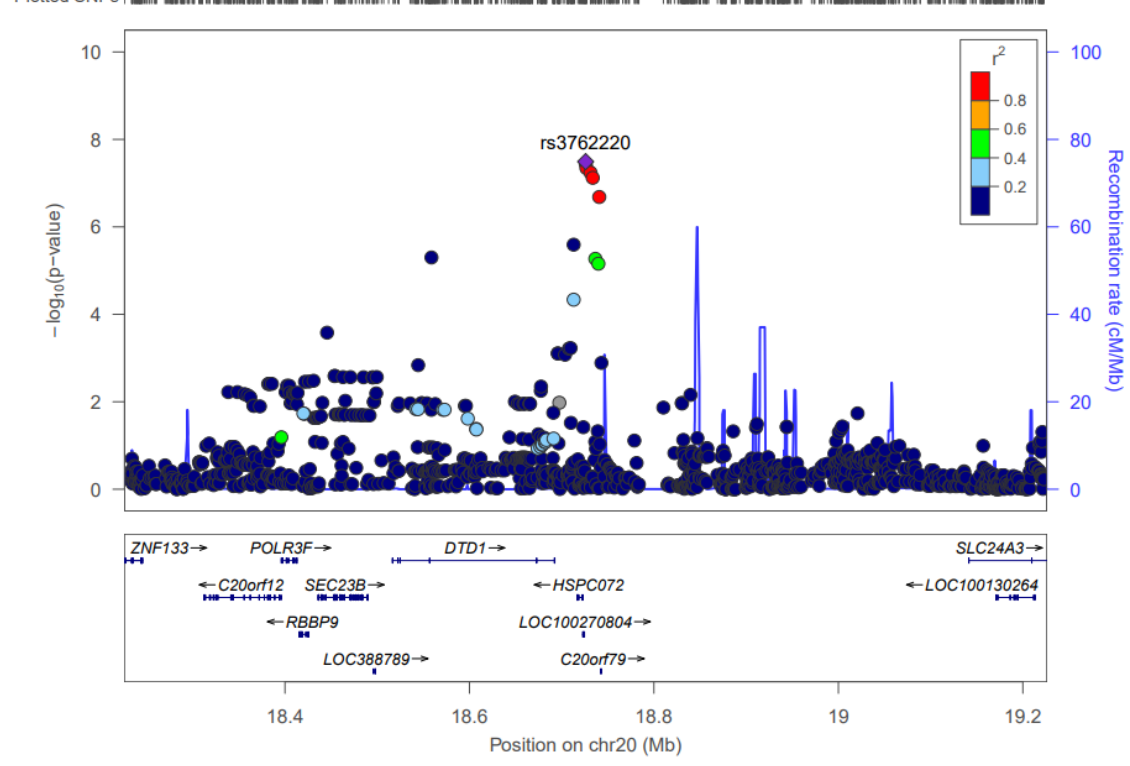
Figure 5. LocusZoom Plot for rs3762220. This figure shows the linkage disequilibrium and significance pattern of SNPs in and around the SNP rs3762220.